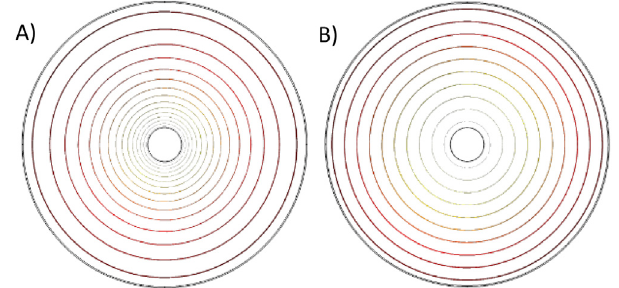
Fig. 4. Isothermal contours of an isotropic copper material (A) and an anisotropic material (B).